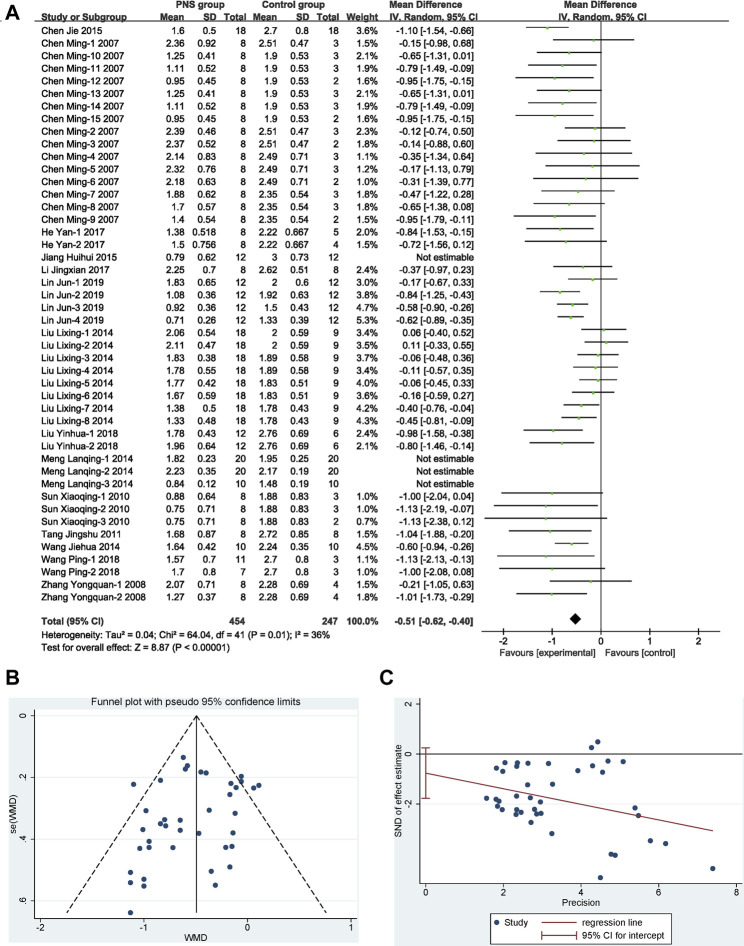
Overall efficacy of PNS on NDS. (A) Results of the meta-analysis visualized in a forest plot. Forest plot adopted mean difference and its corresponding 95% CI based on the random-effects model (Inverse Variance). It is showed that PNS significantly reduced the score of NDS with mild heterogeneity by removing the outlier studies. (B) Assessing of publication bias in a funnel plot. No publication bias could be detected from the symmetrical funnel plot. (C) Bias assessment plot by Egger’s test. Egger’s weighted regression suggested no publication bias for all analyses.